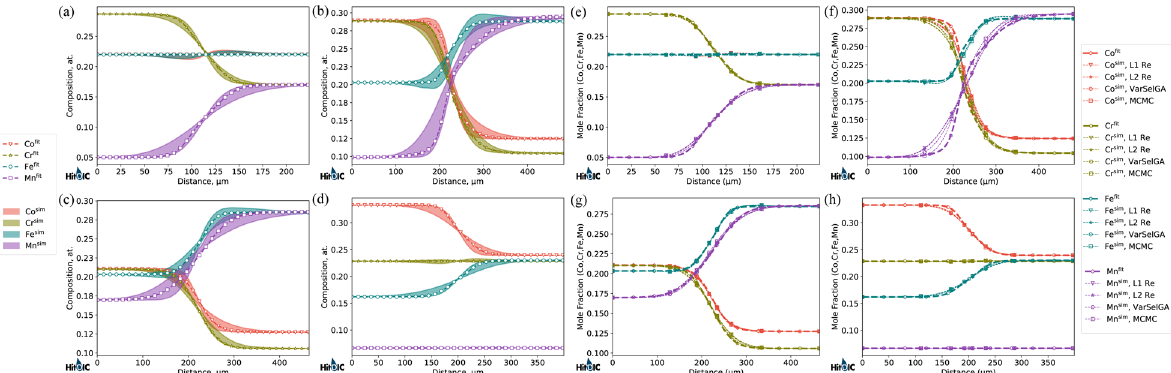
Fig. 6 Examples of fi tted and model-predicted composition pro fi les. Composition pro fi les for the fcc CoCrFeMnNi high-entropy alloys: a , b , c , and d concern bounds of the composition pro fi les due to uncertainty of the diffusion database; e , f , g , and h concern model-predicted composition pro fi les due to optimization results of different algorithms, i.e., variable-selection genetic algorithm (VarSelGA), L1 norm regularization (L1 Re), L2 norm regularization (L2 Re), and Markov chain Monte Carlo (MCMC). The composition pro fi les of the fi tted data (noted as fi t) are ported from Tsai et al. 6 for ( a ) and ( e ), Kucza et al. 7 for ( b ) and ( f ), D ą browa et al. 8 for ( c ) and ( g ), and Chen and Zhang 11 for ( d ) and ( h ).